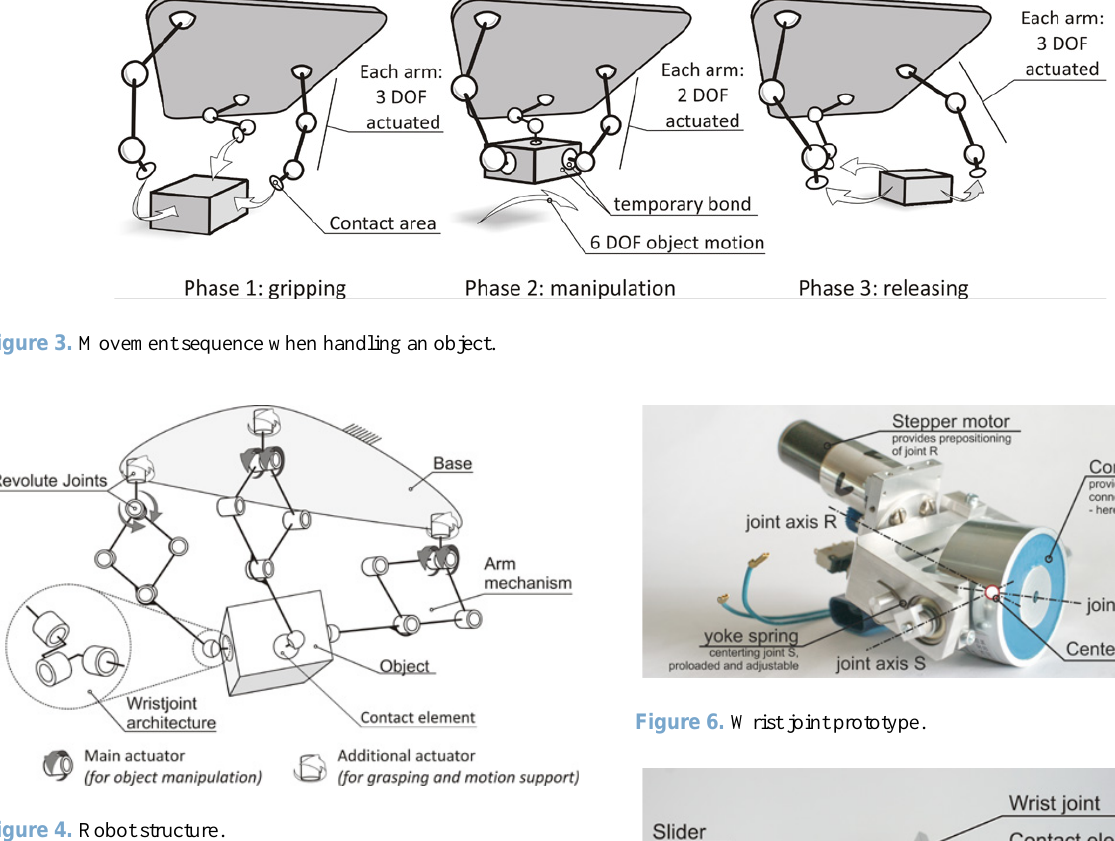
Figure 4. Robot structure.